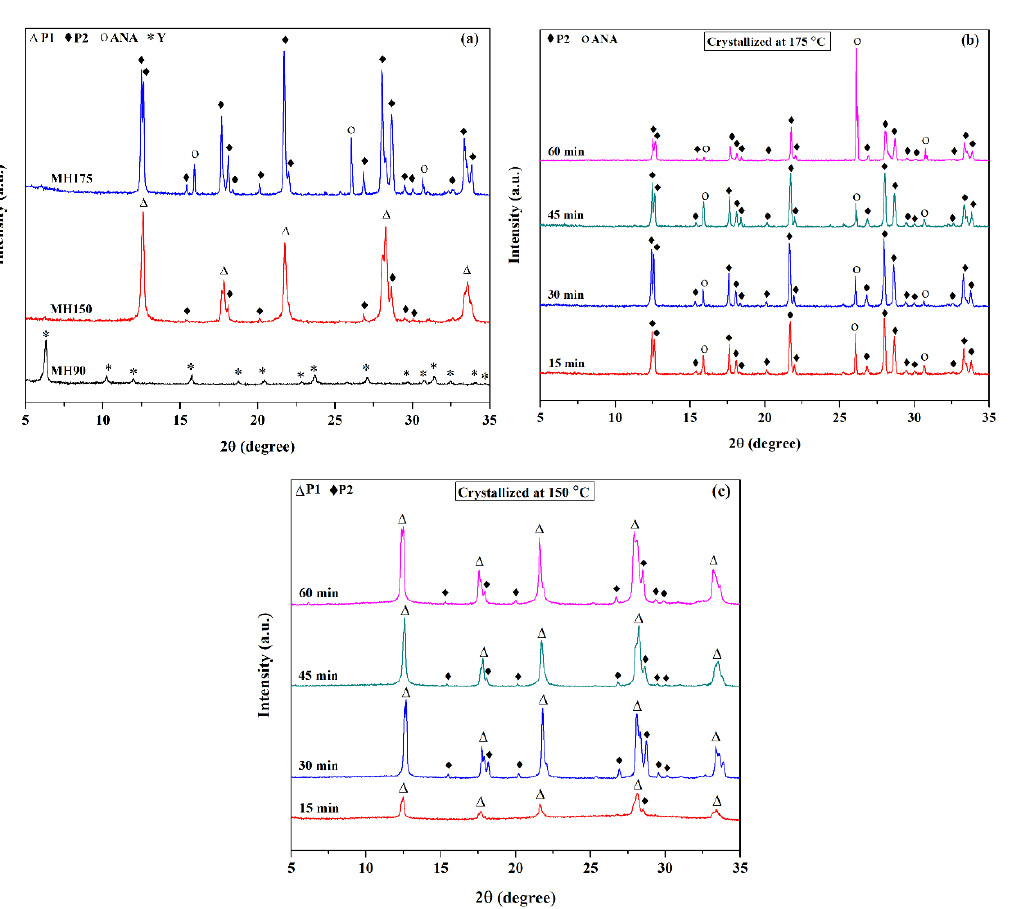
Figure 4. FESEM images of zeolite products from microwave-assisted hydrothermal methods with single crystallization at 210 ˚C for various times: ( a ) 15, ( b ) 30, ( c ) 45 and ( d ) 60 min.